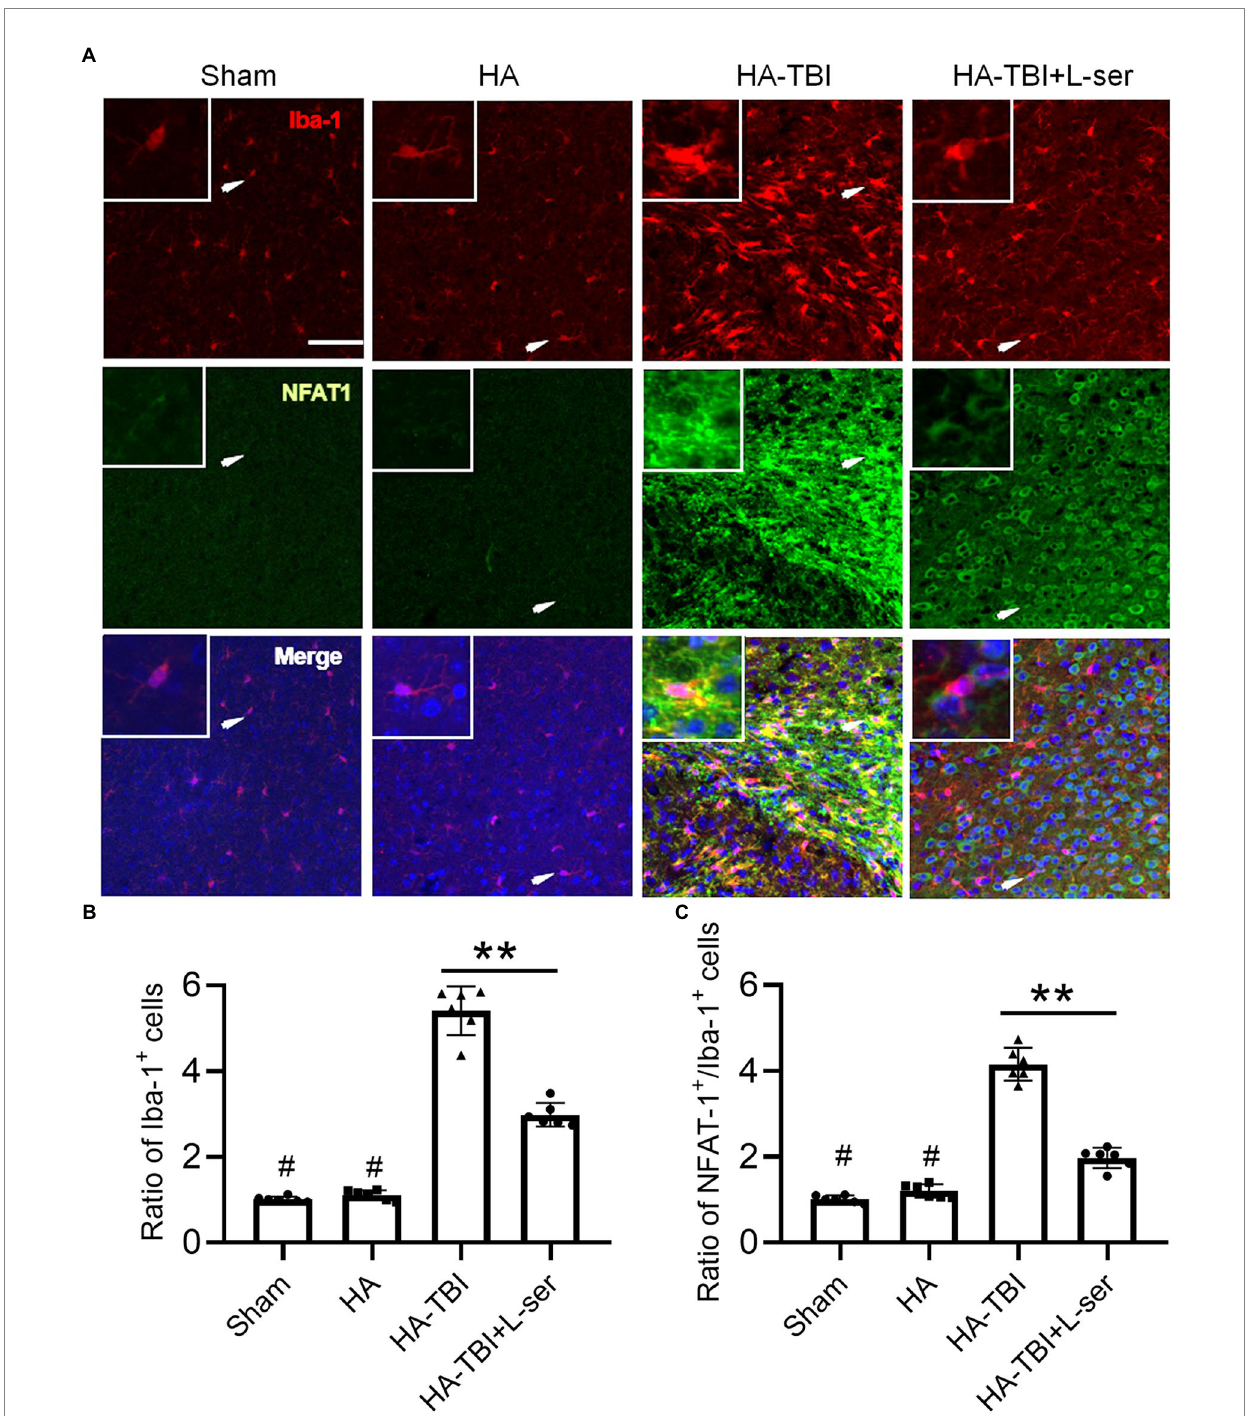
FIGURE 5 Effects of L-serine on the expression of Iba-1 and Nfat1 after HA-TBI. (A) Representative images of double immunofluorescence staining of NFAT1 with Iba-1 in the ipsilateral cortex in different groups. (B) Relative ratio of Iba-1-positive cells. (C) Relative counts of NFAT1+/Iba-1 + cells in the lesion sites. n = 6; scale = 50 μ m. * p < 0.05, ** p < 0.01 versus the indicated group; # p < 0.01 versus other